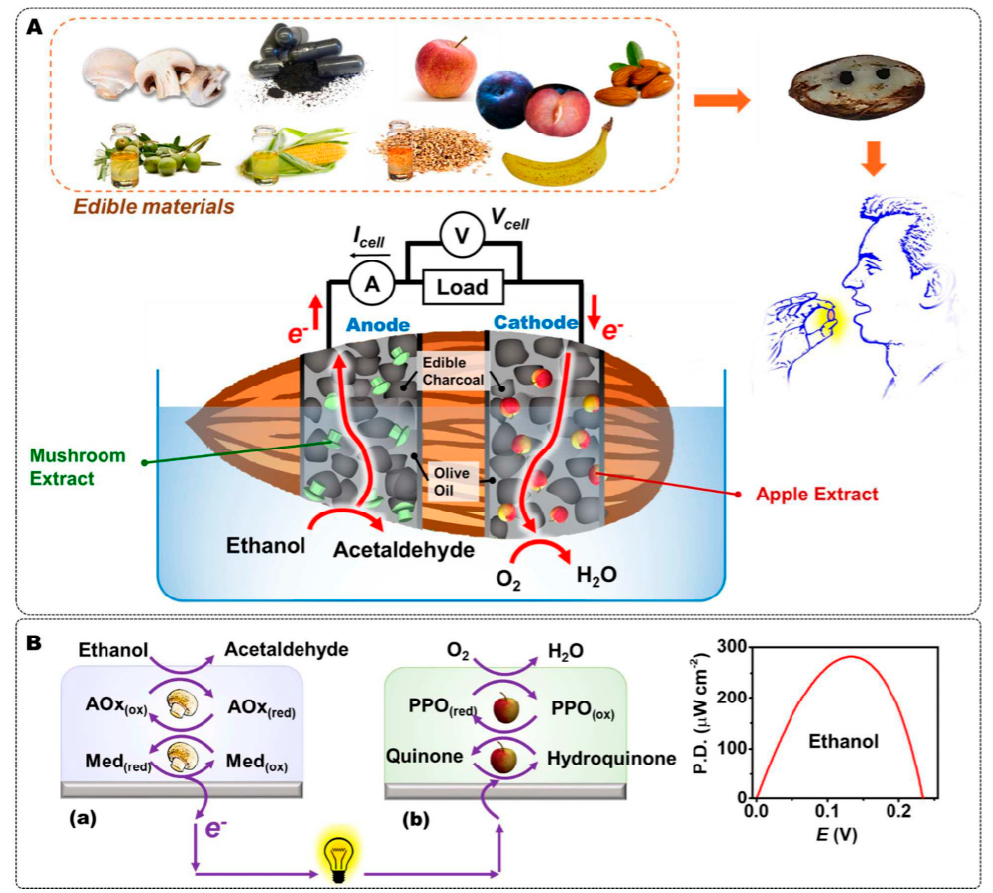
Figure 34. ( A ) Schematic of the edible ethanol biofuel cell serving as ethanol sensor, into which all components come from edible products. ( B ) Reactions occuring at the anodic and cathodic compartments. AOx is for alcohol oxidase, while PPO is for polyphenol oxidase. The maximum power developped by this device is ca. 280 μ W cm − 2 at open circuit. Reproduced from [153] with permission. Copyright 2018 Royal Society of Chemistry.